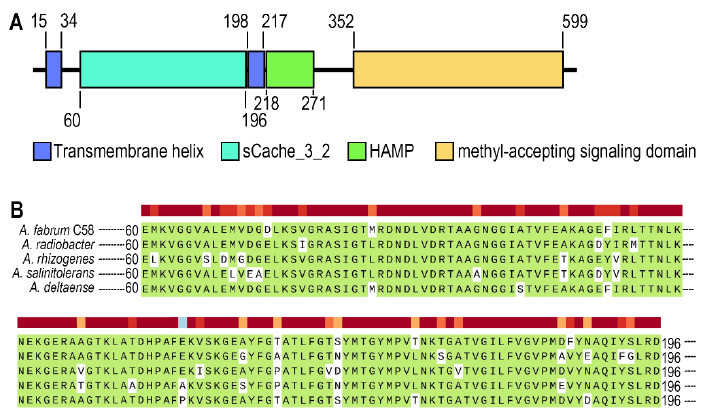
Figure 1. The analysis of Atu0526. ( A ) Domains of Atu0526 predicted by SMART server. The full-length sequence of Atu0526 was input into the SMART server for prediction, and the resulted domains were presented in the linear structure of Atu0526 as rectangles with different colors. The numbers represent the starting and ending positions of each domain. ( B ) sCache domain of Atu0526 was aligned with homologous proteins including Ach5_04520 from A. radiobacter , A8L48_17305 from A. rhizogenes , AGR9A_Cc210166 from A. slinitolerans and AGR7C_Cc260167 from A. deltaense . The color above the sequences represents the degree of protein conservation. The green background indicates the identical residues.